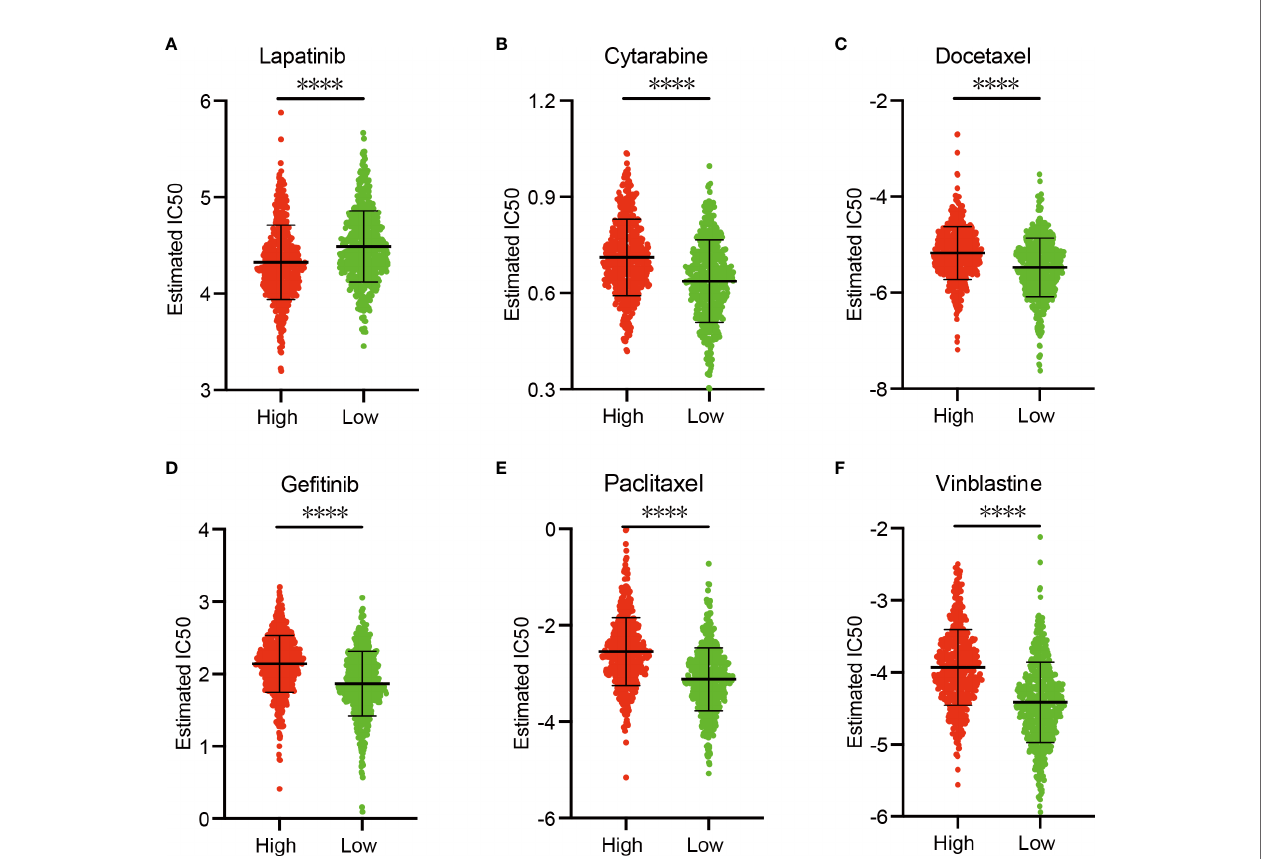
FIGURE 9 | Sensitivity of chemotherapy drugs. (A – F) Difference in the estimated IC50 levels of Lapatinib (A) , Cytarabine (B) , Docetaxel (C) , Ge fi tinib (D) , Paclitaxel (E) , and Vinblastine (F) . Data are shown as means±S.D. ns: not signi fi cant, *p<0.05, **p<0.01, ***p<0.001, ****p<0.0001.